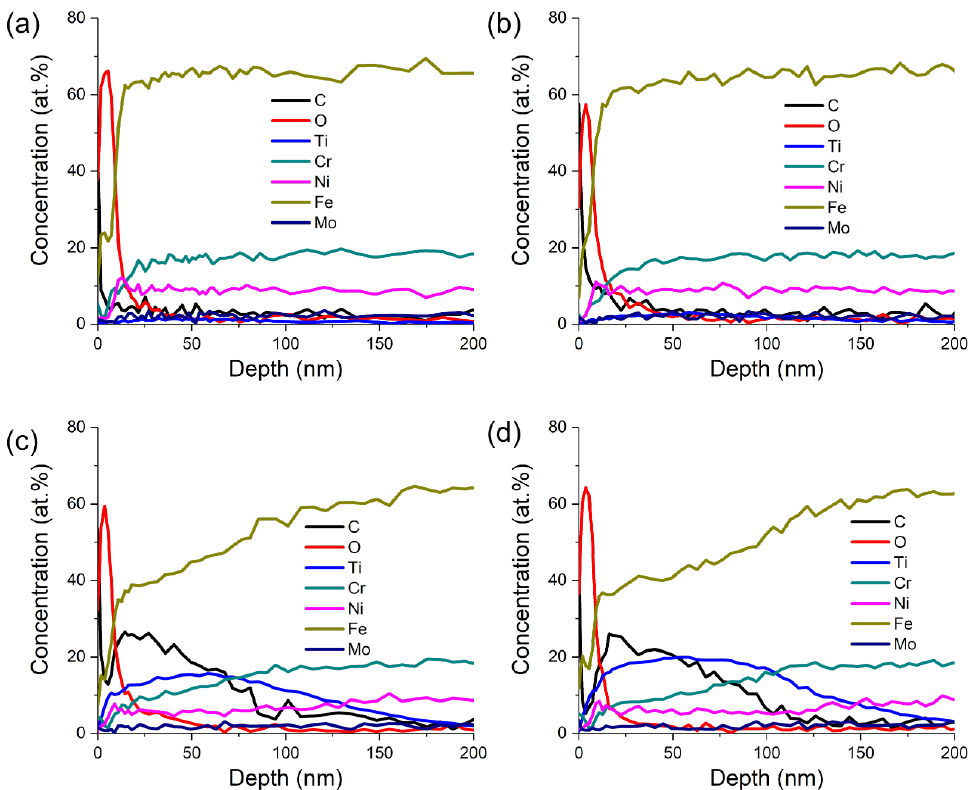
Figure 2. Elemental depth profiles of titanium-implanted samples obtained by sputtering Auger electron spectroscopy (AES) with different Ti ion-implanted doses: ( a ) 3.0 × 10 16 ions/cm 2 , ( b ) 1.0 × 10 17 ions/cm 2 , ( c ) 1.0 × 10 18 ions/cm 2 , and ( d ) 1.7 × 10 18 ions/cm 2 .